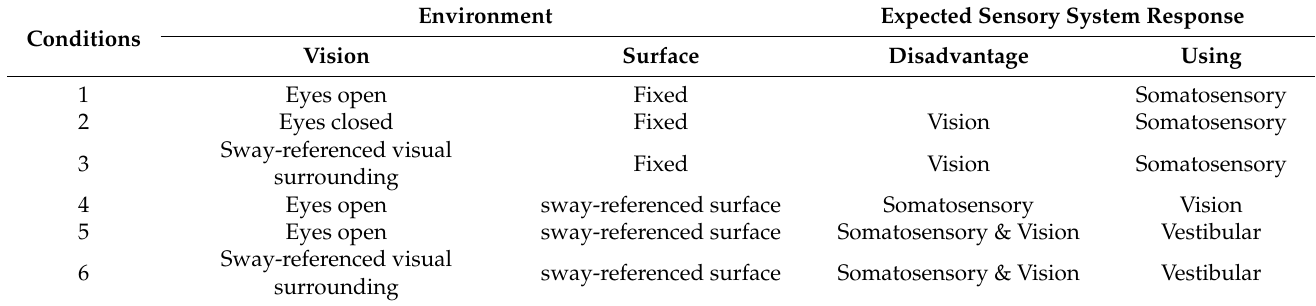
Figure 3. Six conditions of sensory organization test. Table 2. Description of the six sensory organization test tasks.